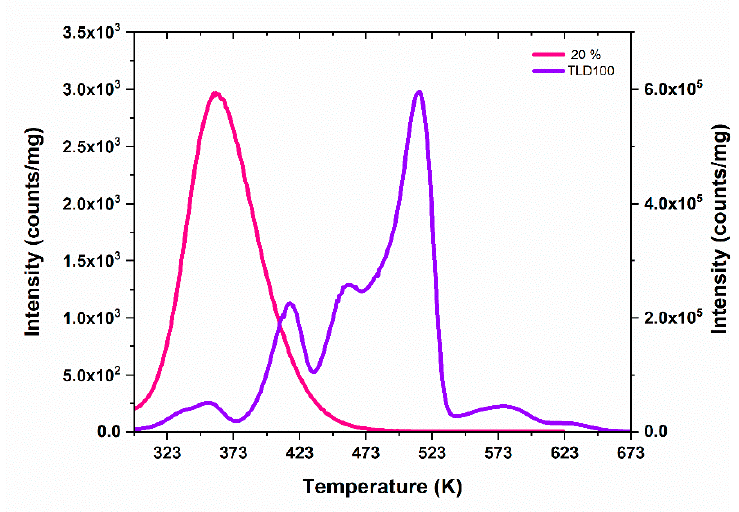
Figure 6. Comparison of the TL response of xNaF (100 − x)BaO · 2B 2 O with x = 20% with the corresponding of the phosphor TLD-100.